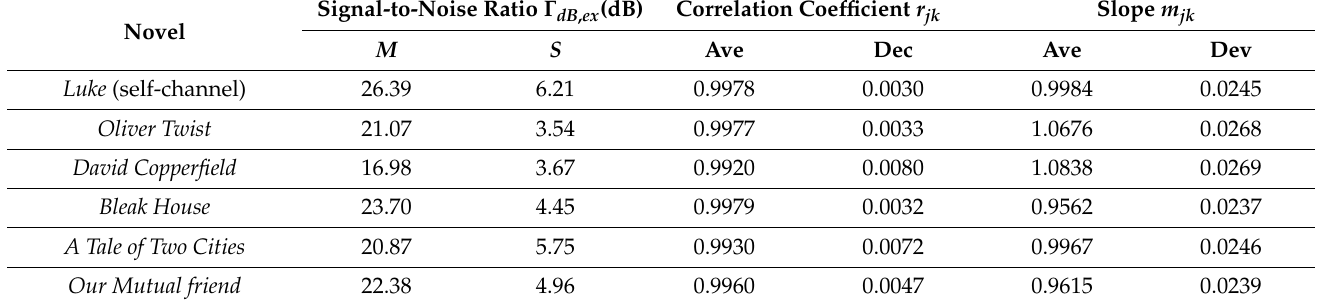
Table A2. Average value M (dB) and standard deviation S (dB) of Γ dB , ex (dB) in self- and cross- channels, correlation coefficient r jk , and slope m jk of the regression line between the number of sentences n S of Luke (channel output, self-channel) versus the number of sentences n S in Dickens’ novels (channel input, cross-channels), for equal number of words, in the sentences channel.